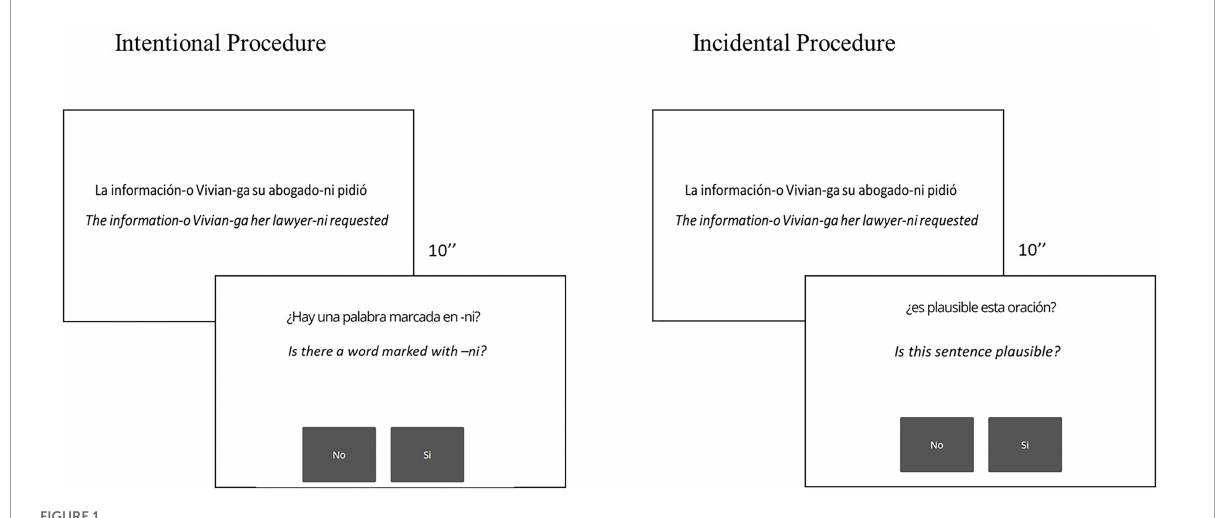
FIGURE1 Learning task conditions: Incidental and